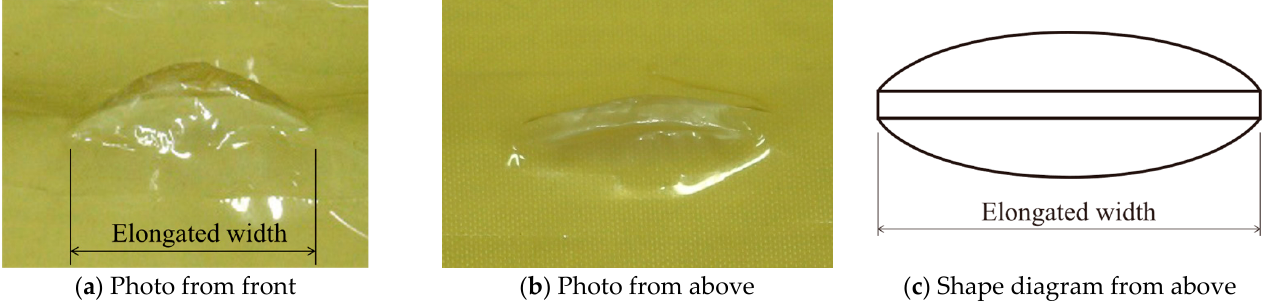
Figure 10. Photograph of molded pod structure on PI film and measured elongated width: ( a ) photograph from front; ( b ) photograph from above; ( c ) schematic diagram of molded shape from above.